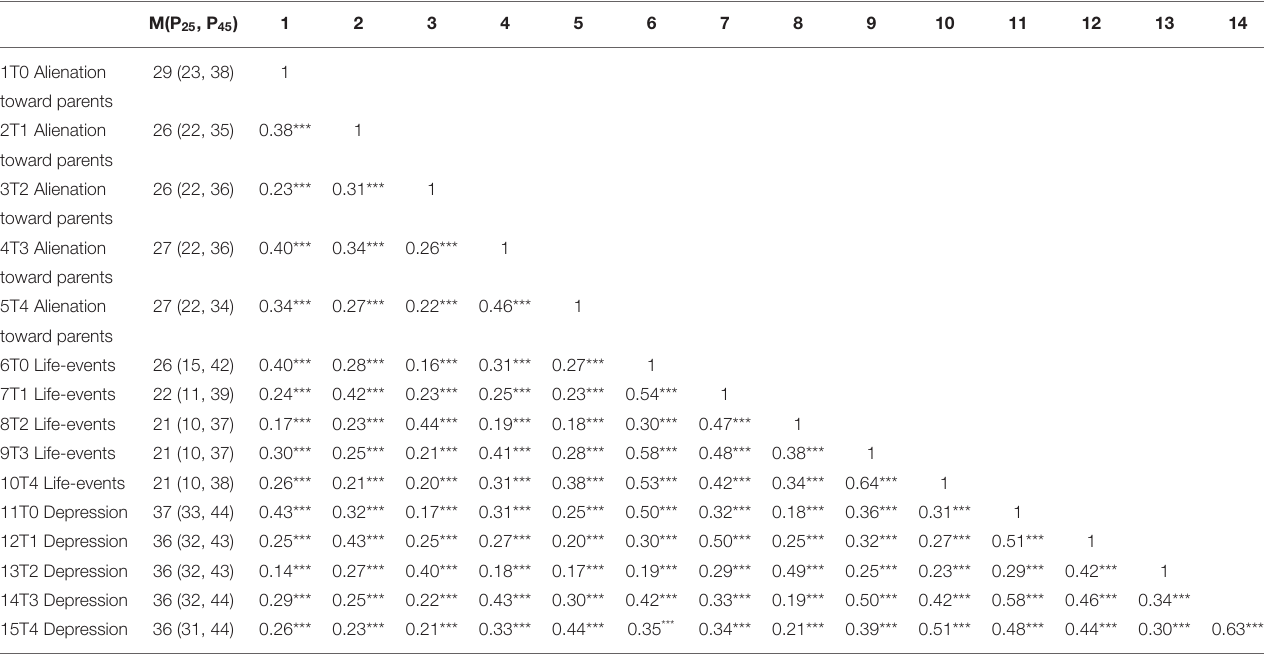
TABLE 2 | Correlations between depression, alienation toward parents, and life-events between five investigations. M(P 25 , P 45